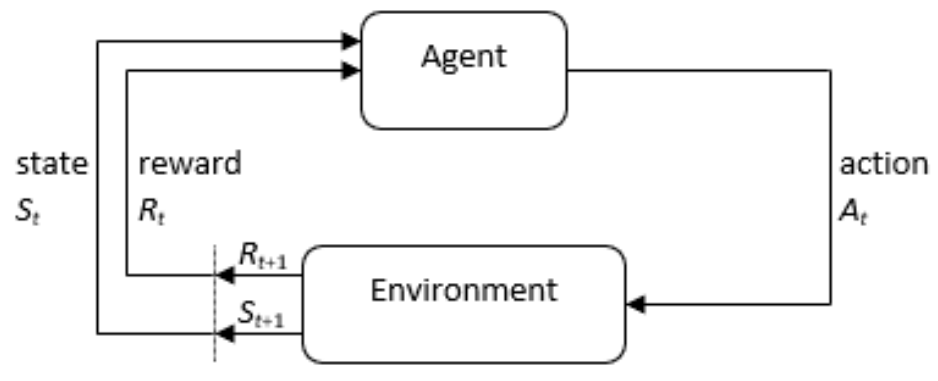
Figure 1. Reinforcement